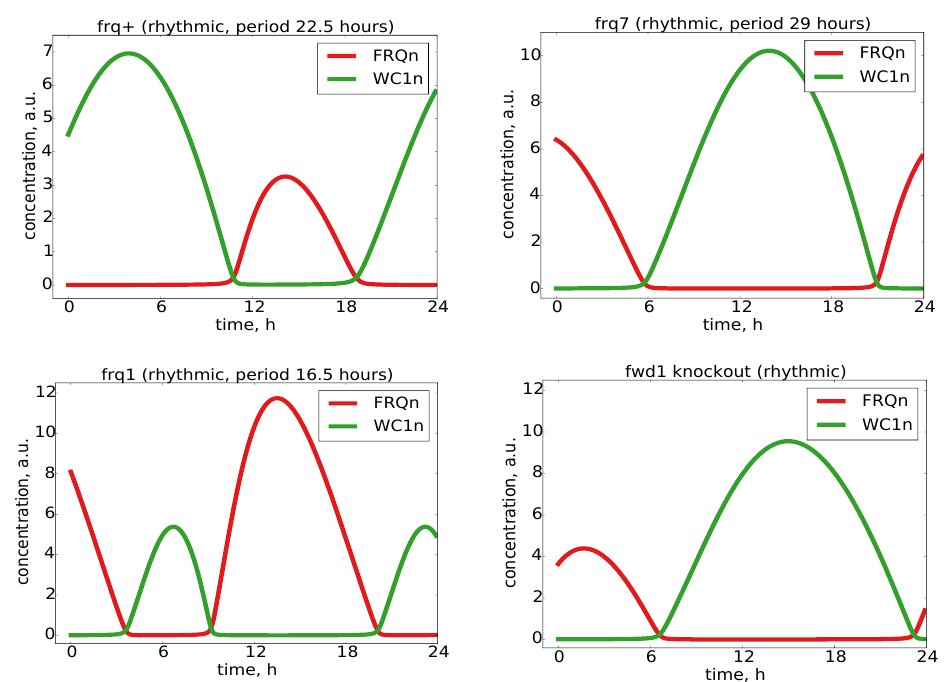
Figure A5. Mutant simulations: Several experimentally-observed mutants were also reproduced by our model. The corresponding modified parameters are given in Table